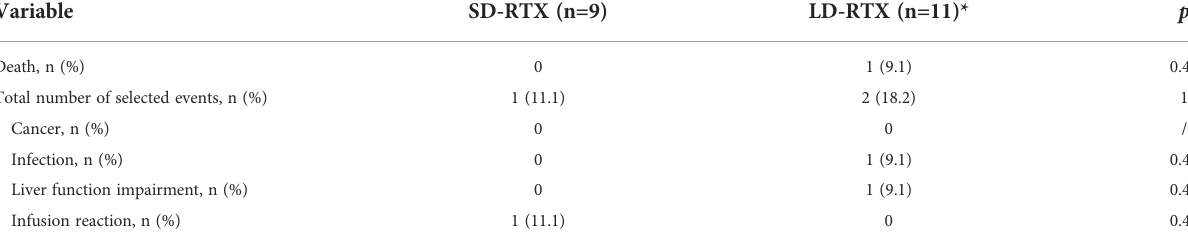
TABLE 5 Adverse events at 6